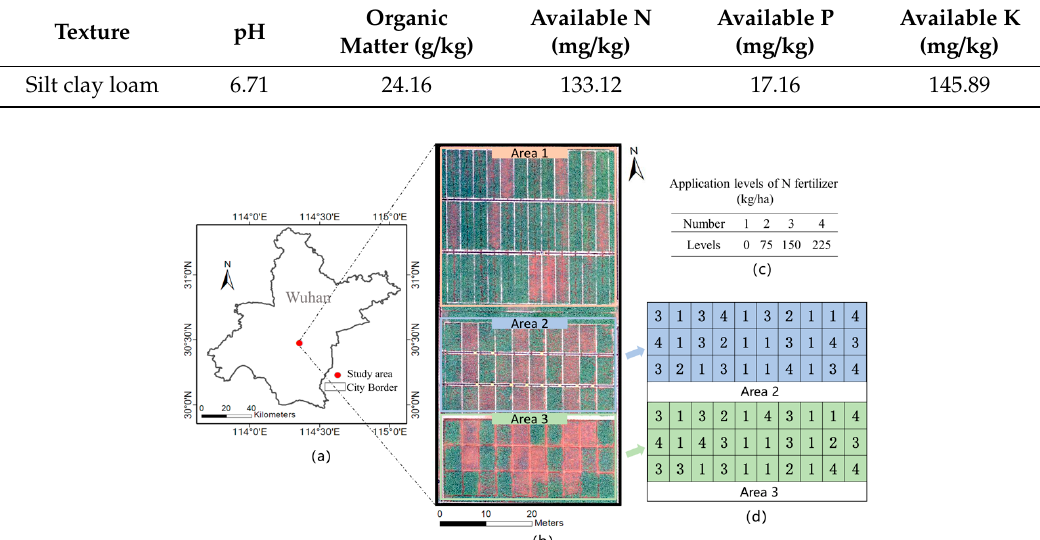
Table 1. Main physicochemical properties of the soil in the study area.